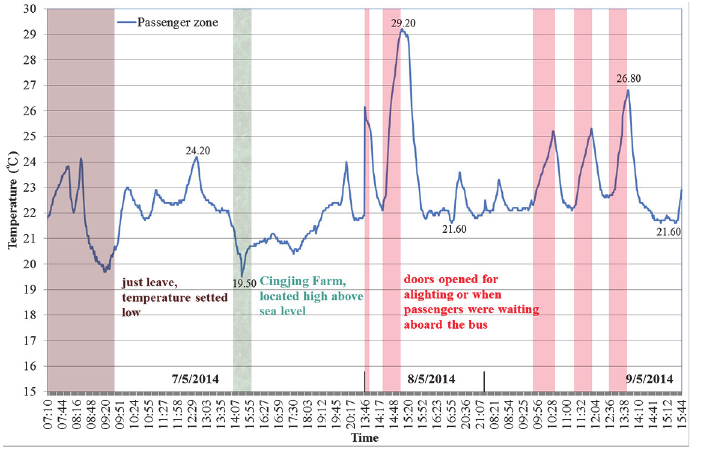
Fig 2. Air temperature in the tour bus A as a function of